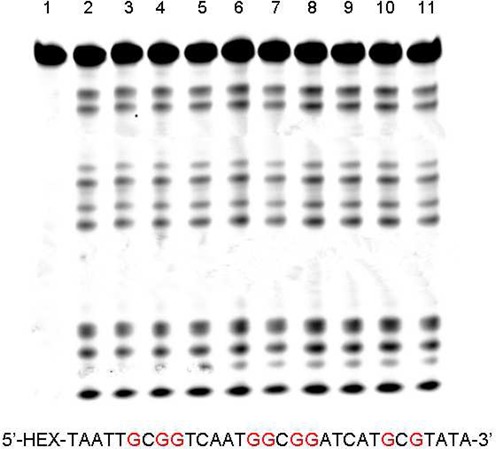
Polyacrylamide gel electrophoresis analysis of 31mer-DNA. Treatment of the ODN (20 pmol) with piperidine at 90°C for 30 min, after oxidized by 20 mM K2WO4 and 200 mM H2O2. The reacting time in lanes 1–11 was 0, 1, 2, 3, 4, 5, 6, 7, 8, 9 and 10 min, respectively.